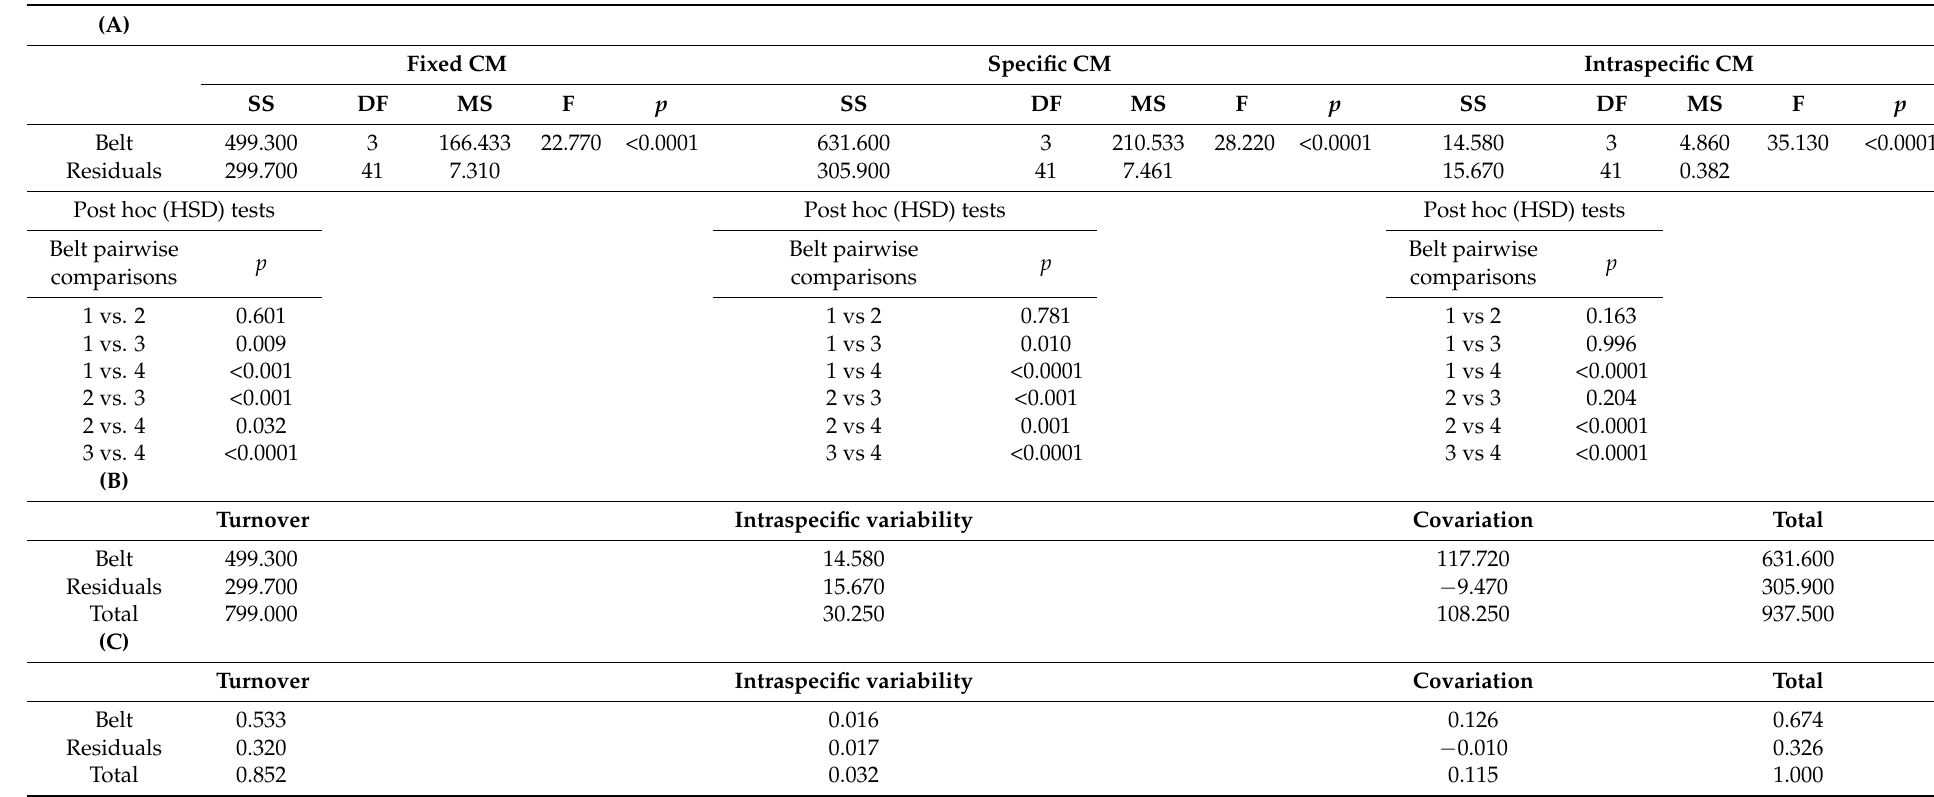
Table 2. Results of ANOVAs for CM of plant height (H). ( A ) ‘Fixed’ and ‘specific’ averages and intraspecific variability effect were analyzed separately (one-way ANOVA), followed by post hoc (HSD) tests for pairwise comparisons. ( B ) Variability of individual components of trait variation (turnover, intraspecific and their covariation) between belts. ( C ) Proportions of variability of individual components and their parts explained by elevation (belt). For details, see Table